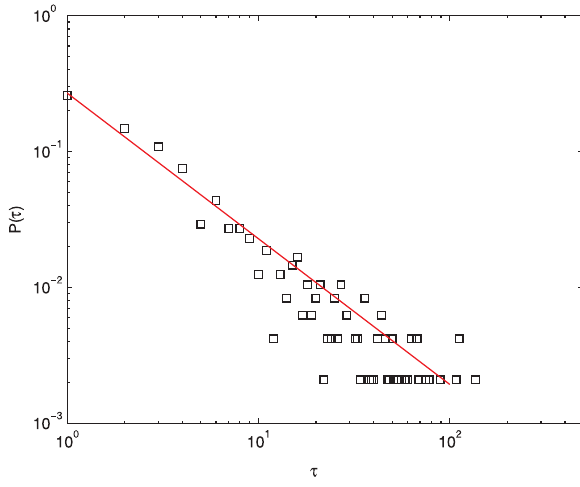
Figure 5. Number of posts varying their number of replies after 200 time steps, N ~ 5000 , l ~ 0 : 002 , and d ~ 0 : 5 . This distribution decays as a power law along with a long tail. The power exponent is { 1 : 16 + 0 : 051 .